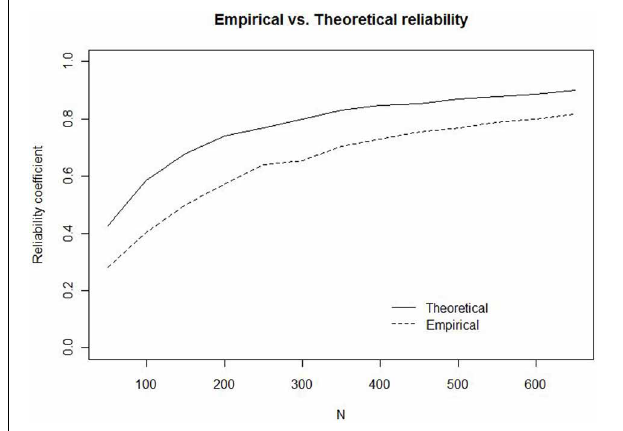
FIGURE 2 | Empirical (dashed line) and Theoretical (solid line) reliability for w as a function of the number of trials ( N